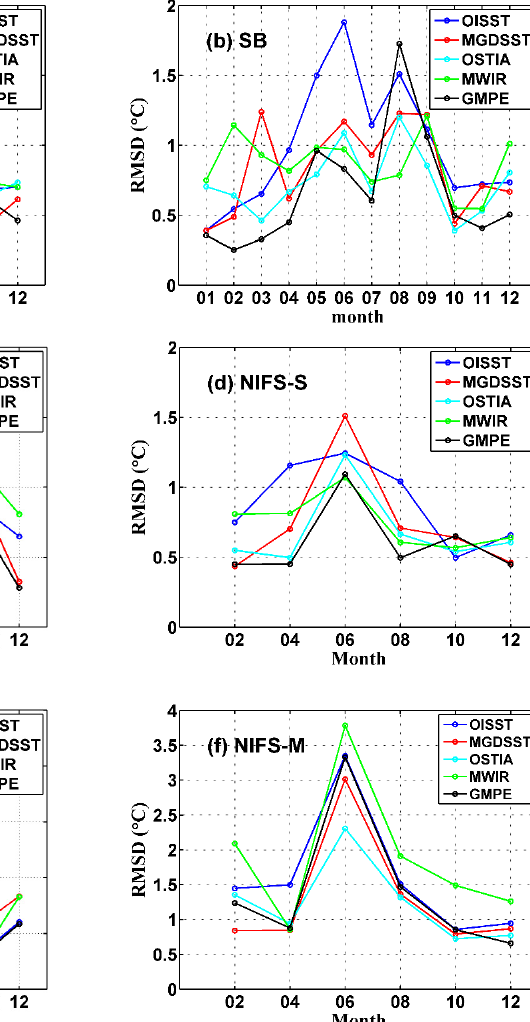
Figure 5. Seasonal variations in the monthly mean RMSD (°C) between the in situ SST and the global gridded SST data. ( a ) KB, ( b ) SB, ( c ) O, and ( e ) D represent the in situ observations collected at the ocean surface buoy stations. ( d ) NIFS-S and ( f ) NIFS-M represent the in situ CTD observations from the deep stratified region (h > 50 m) and the shallow vertically mixed region (h < 50 m) stations, respectively, along the routine bimonthly observation lines of the research vessels. Note that the vertical ranges in ( e ) and ( f ) are different from those in the other panels.